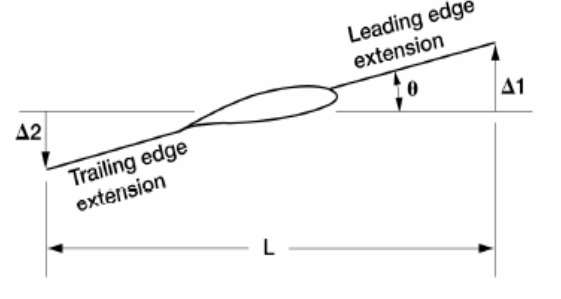
Figure 6. Sectional rotational field At the lifting surface, selected chords previously calculated displacements of leading and trailing edges are imposed as boundary conditions (enforced disp– lacement), as it is shown in Figure 7.